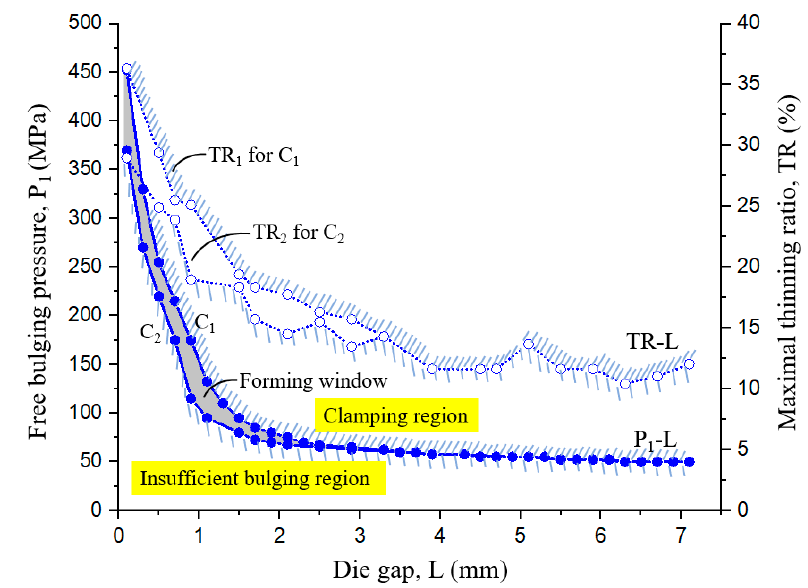
Figure 9. Forming windows and maximal thinning ratios for feeding type 1.